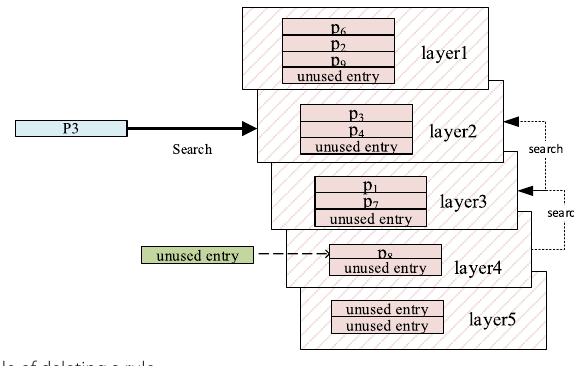
Fig. 8 An example of deleting a